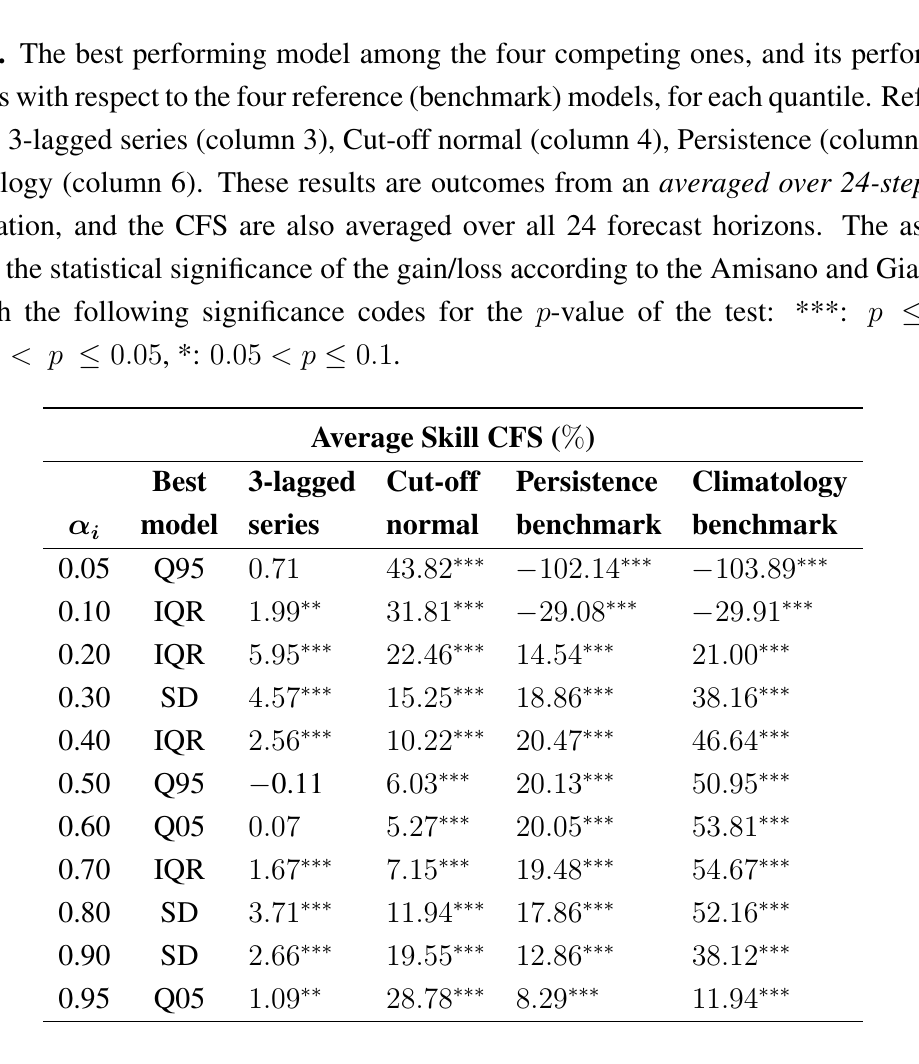
Table 8. The best performing model among the four competing ones, and its performance gain/loss with respect to the four reference (benchmark) models, for each quantile. Reference models: 3-lagged series (column 3), Cut-off normal (column 4), Persistence (column 5) and Climatology (column 6). These results are outcomes from an averaged over 24-steps